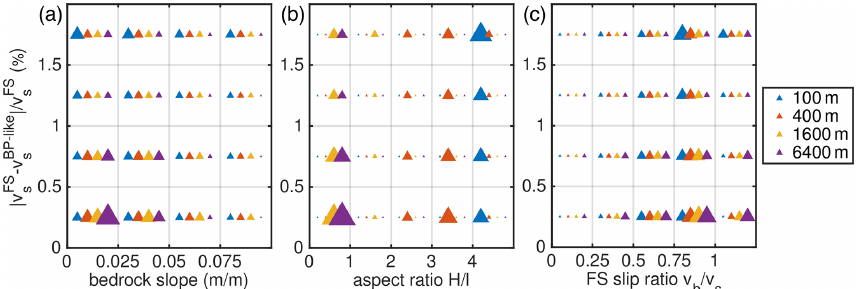
Figure 13. Two-dimensional histograms for E = 1, m = 1, P1P1GLS strong and four different grid resolutions for the ice-stream region. Counts of grid nodes per relative velocity error bin and per (a) bed slope bin, (b) local aspect ratio bin and (c) FS slip ratio bin. The sizes of the triangles are normalized by the total number of horizontal grid nodes of each